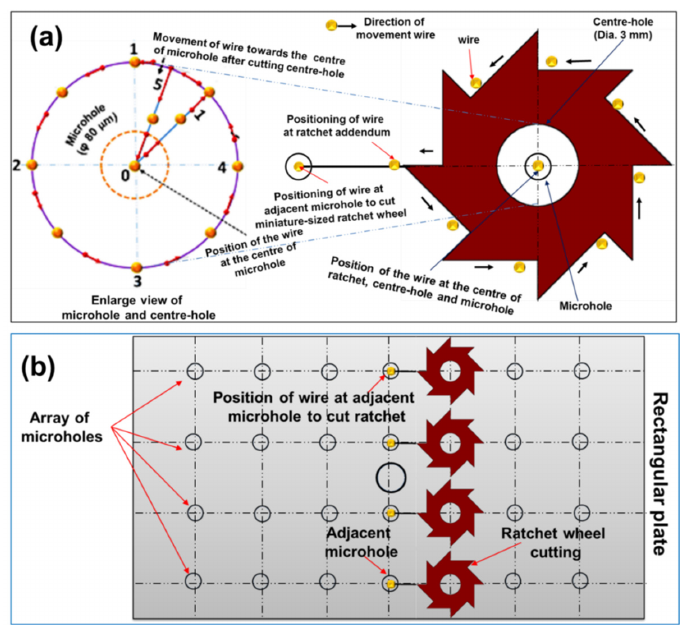
Figure 5. Layout of the miniature-sized ratchet wheel and rectangular plate: ( a ) direction of the wire movements during cutting of center hole and wheels by WEDM process; ( b ) schematic view of a plate with microholes.